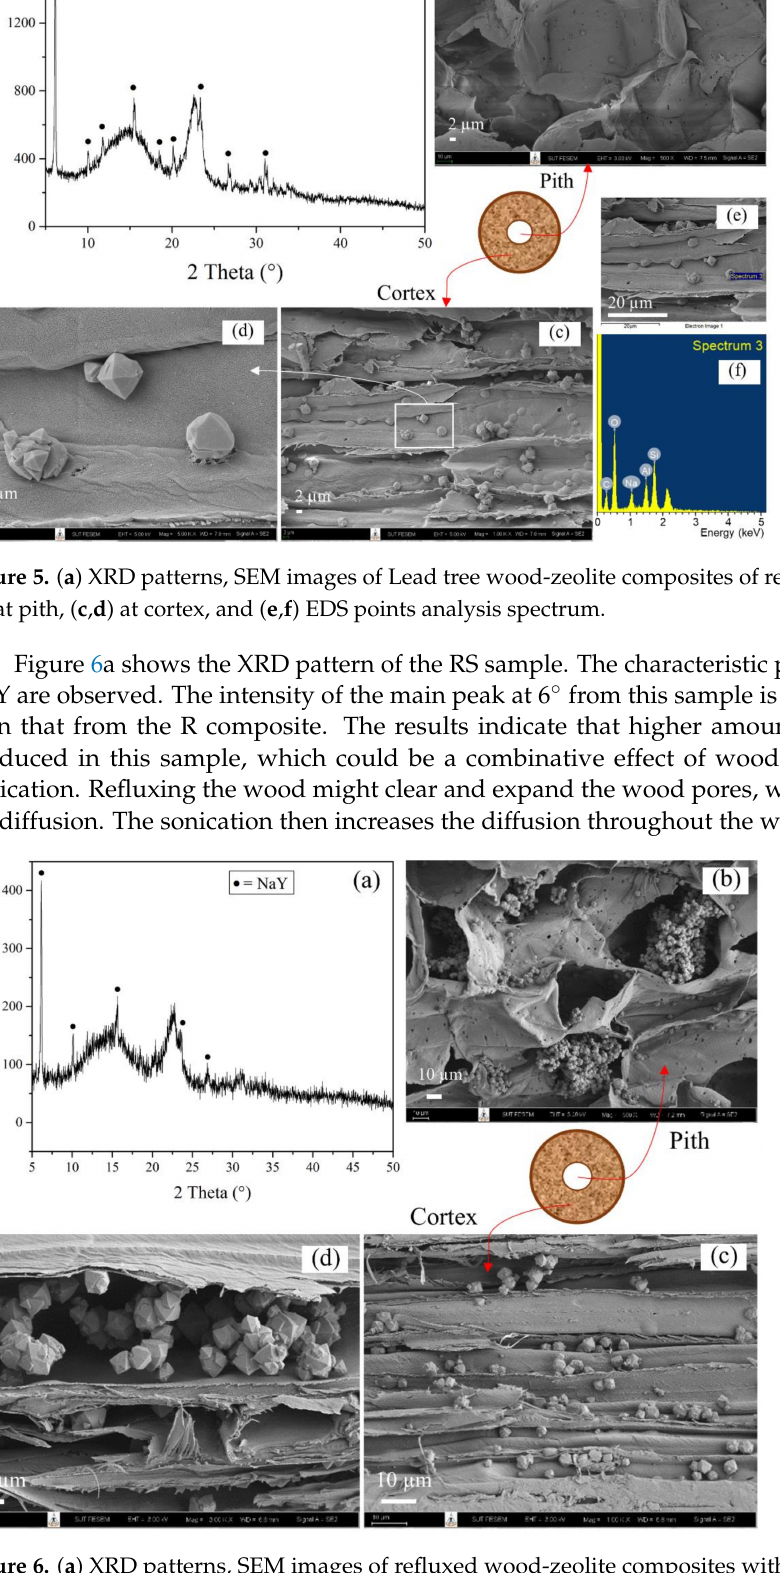
Figure 6. ( a ) XRD patterns, SEM images of refluxed wood-zeolite composites with sonication (RS) ( b ) at pith, and ( c , d ) at